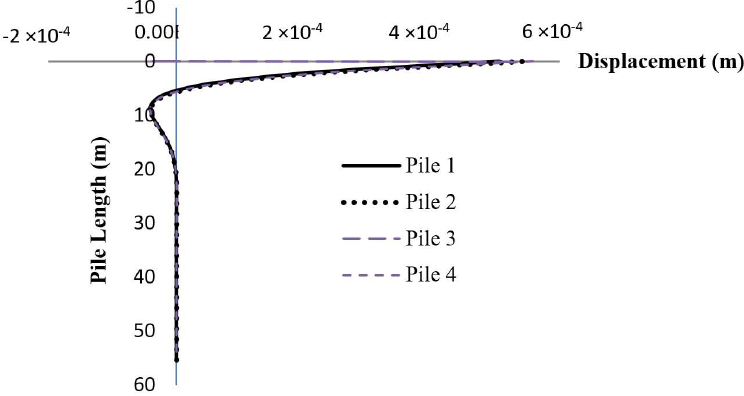
Figure 18. The maximum distribution of displacement along the pile length in the lateral direction (x).